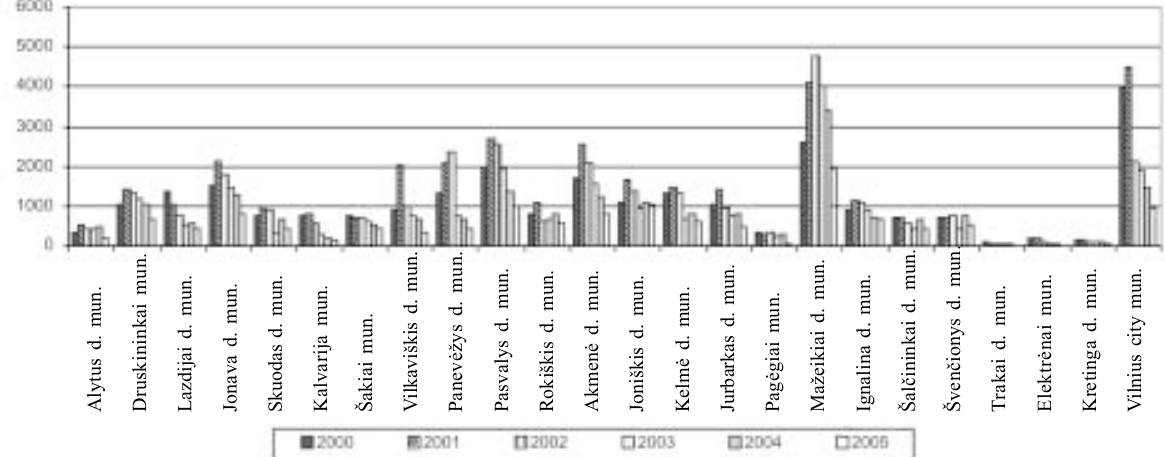
Fig 2. Number of long-term unemployed individuals in depressive regions of Lithuania in